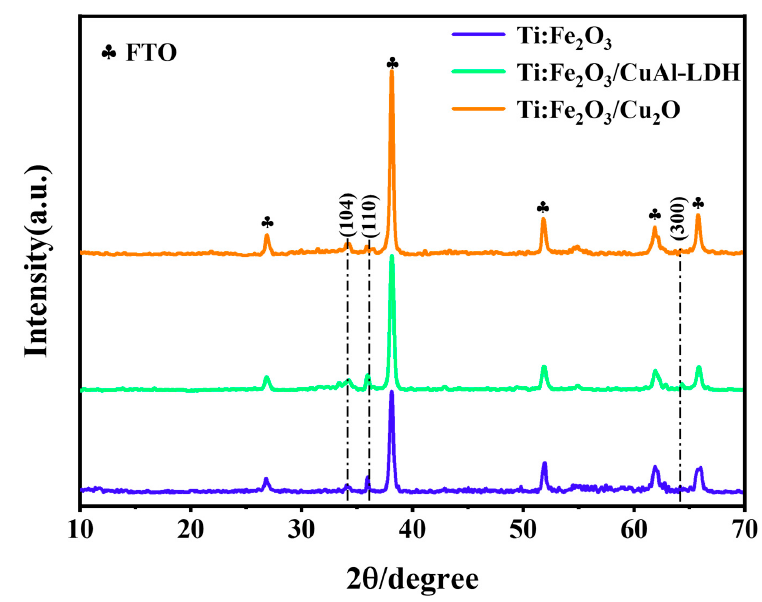
Figure 2. XRD pa tt erns of Ti:Fe 2 O 3 , Ti:Fe 2 O 3 /CuAl-LDH, and Ti:Fe 2 O 3 /Cu 2 O photoanode samples. Figure 2. XRD patterns of Ti:Fe 2 O 3 , Ti:Fe 2 O 3 /CuAl-LDH, and Ti:Fe 2 O 3 /Cu 2 O photoanode